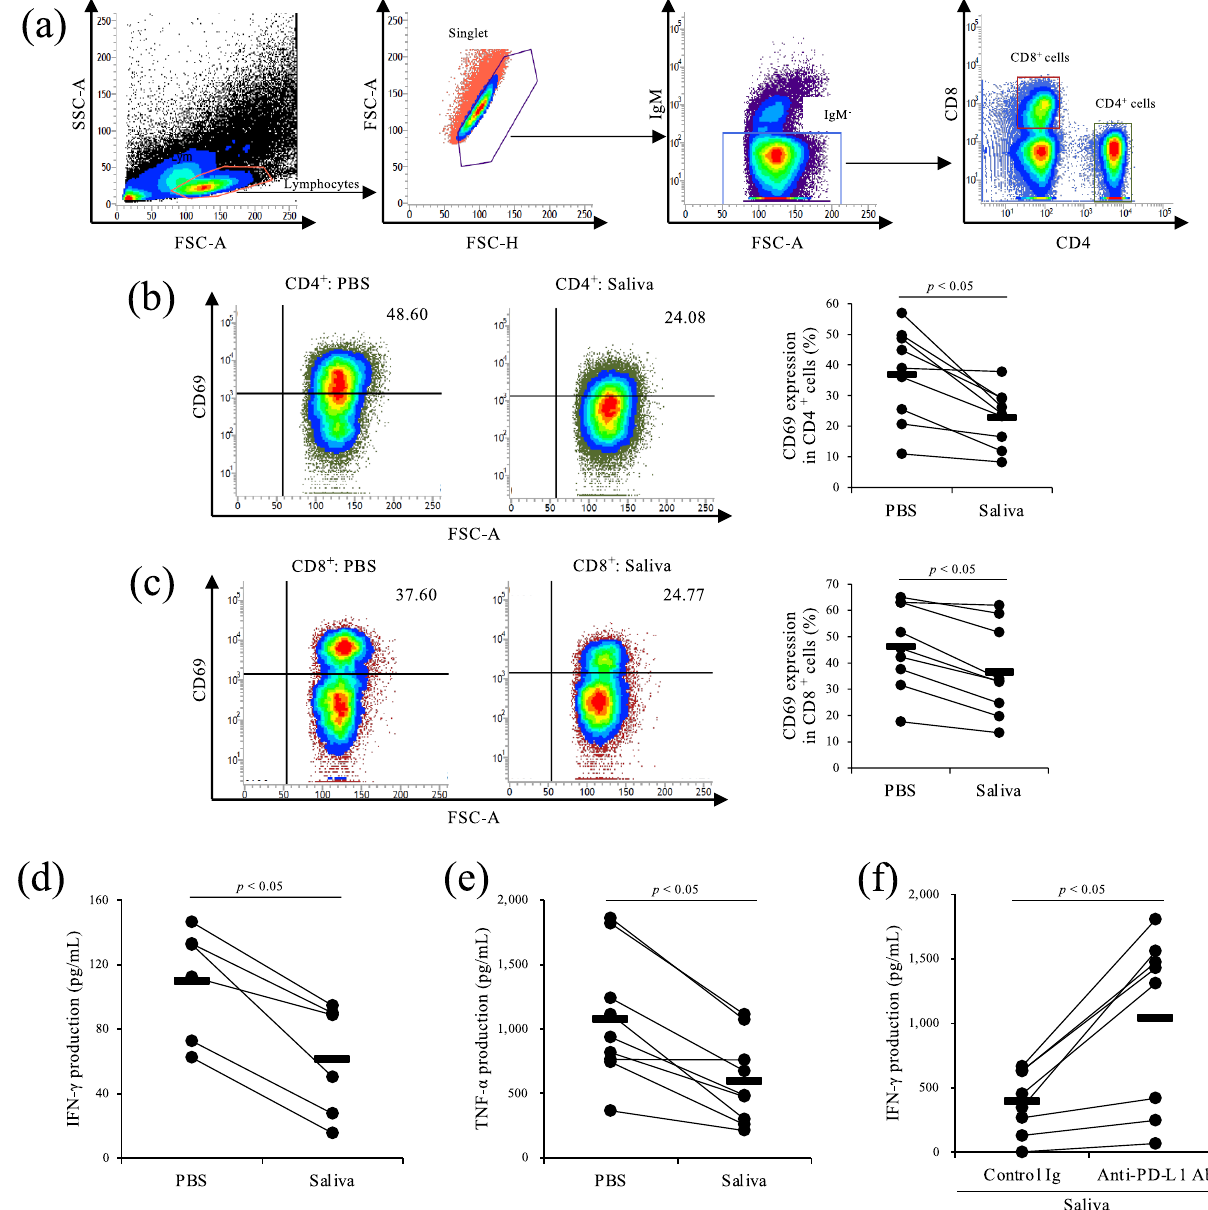
Figure 2. Inhibition of Th1 responses by Rm-saliva. ( a – e ) PBMCs were cultured with Rm-saliva in the presence of anti-CD3 and anti-CD28 mAbs. ( a ) Gating strategy for CD69 expression. ( b , c ) CD69 expression in CD4 + ( b ) and CD8 + ( c ) cells was measured by flow cytometry. ( d , e ) IFN-γ ( d ) and TNF-α ( e ) concentrations in culture supernatants were determined by ELISA. ( f ) PBMCs were cultured with anti-PD-L1 Ab (Boch4G12) in the presence of Rm-saliva. Bovine IgG was used as a control Ab. PBMCs were stimulated by anti-CD3 and anti-CD28 mAbs. IFN-γ concentration was determined by ELISA. ( a – f ) Statistical difference was identified by the Wilcoxon signed-rank